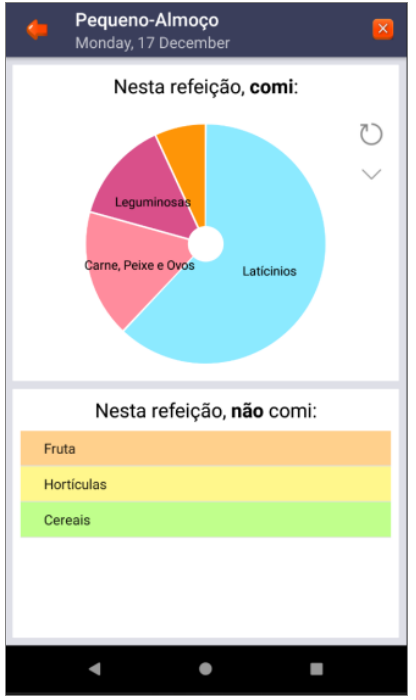
Figure 9. Back button—breakfast (“pequeno-almoço”) with the food intake presented in the wheel (meat = ”carne”, dairy = ”lactic í nios”, . . . ) and the major categories missed in that meal (fruit = ”fruta”, vegetables = ”hort í colas”, cereals = ”cereais”)—mental